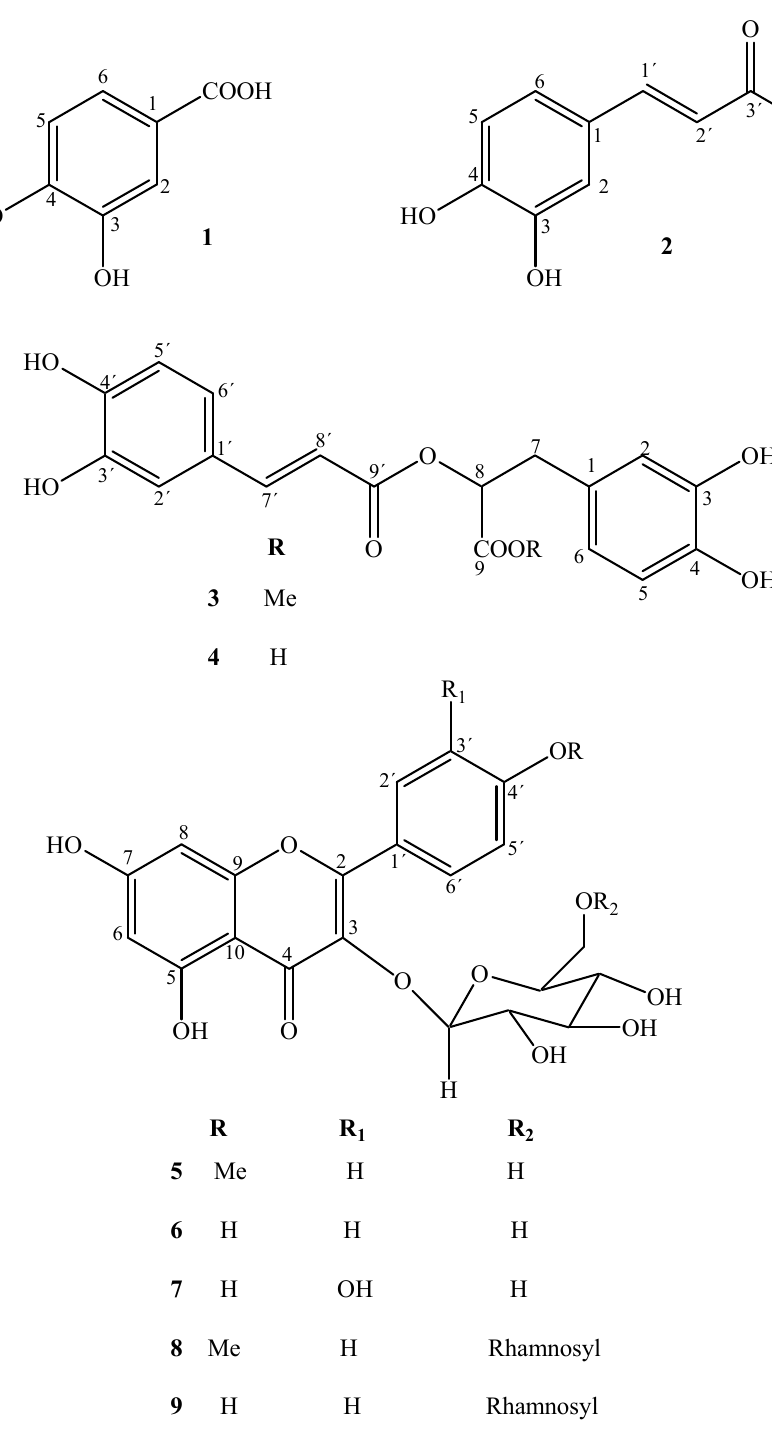
Figure 1. Structures of compounds 1–9